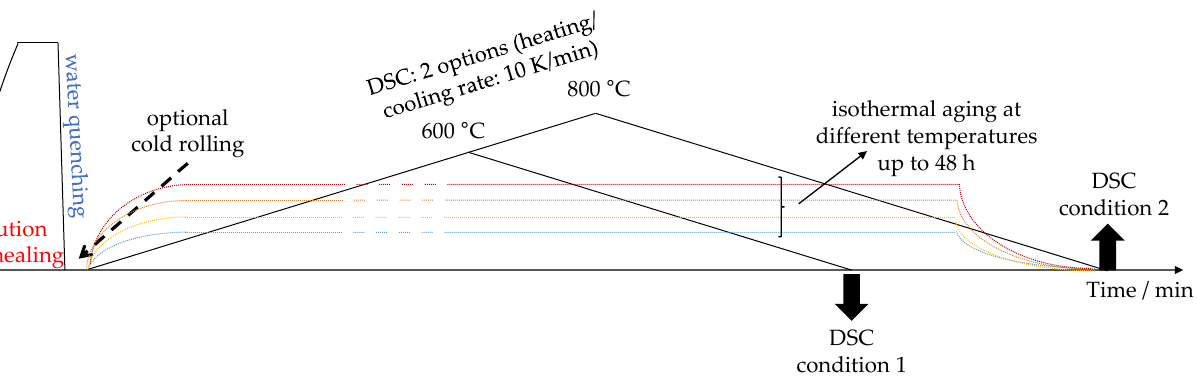
Figure 2. Temperature profile (schematic) for isothermal aging experiments and DSC measure- ments.